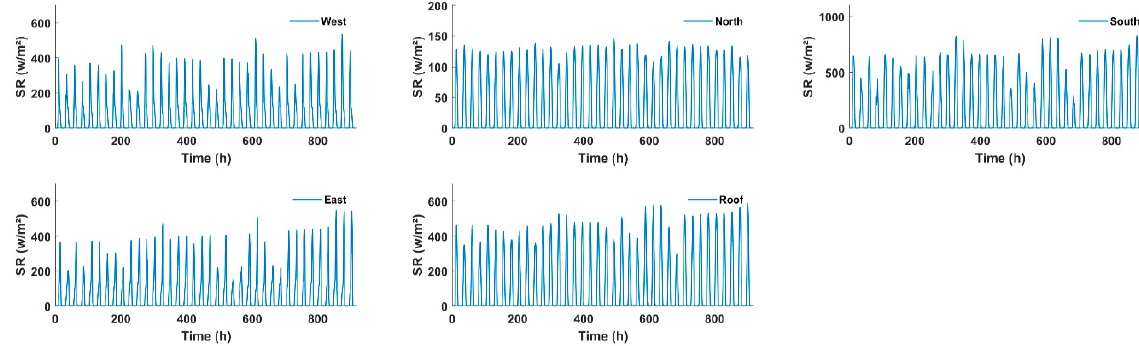
Figure 4. External solar radiation for the considered period among each facade of the EEBLab.